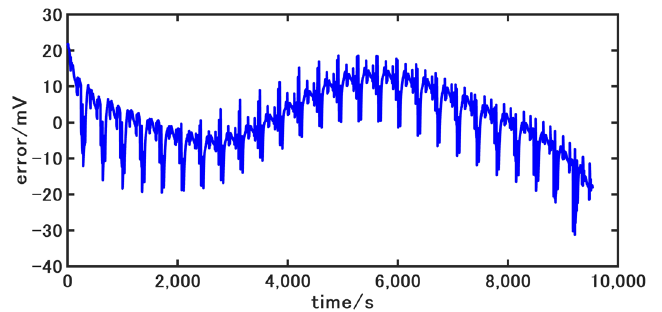
Figure 11. Errors of Terminal Voltage under DST Driving Condition.